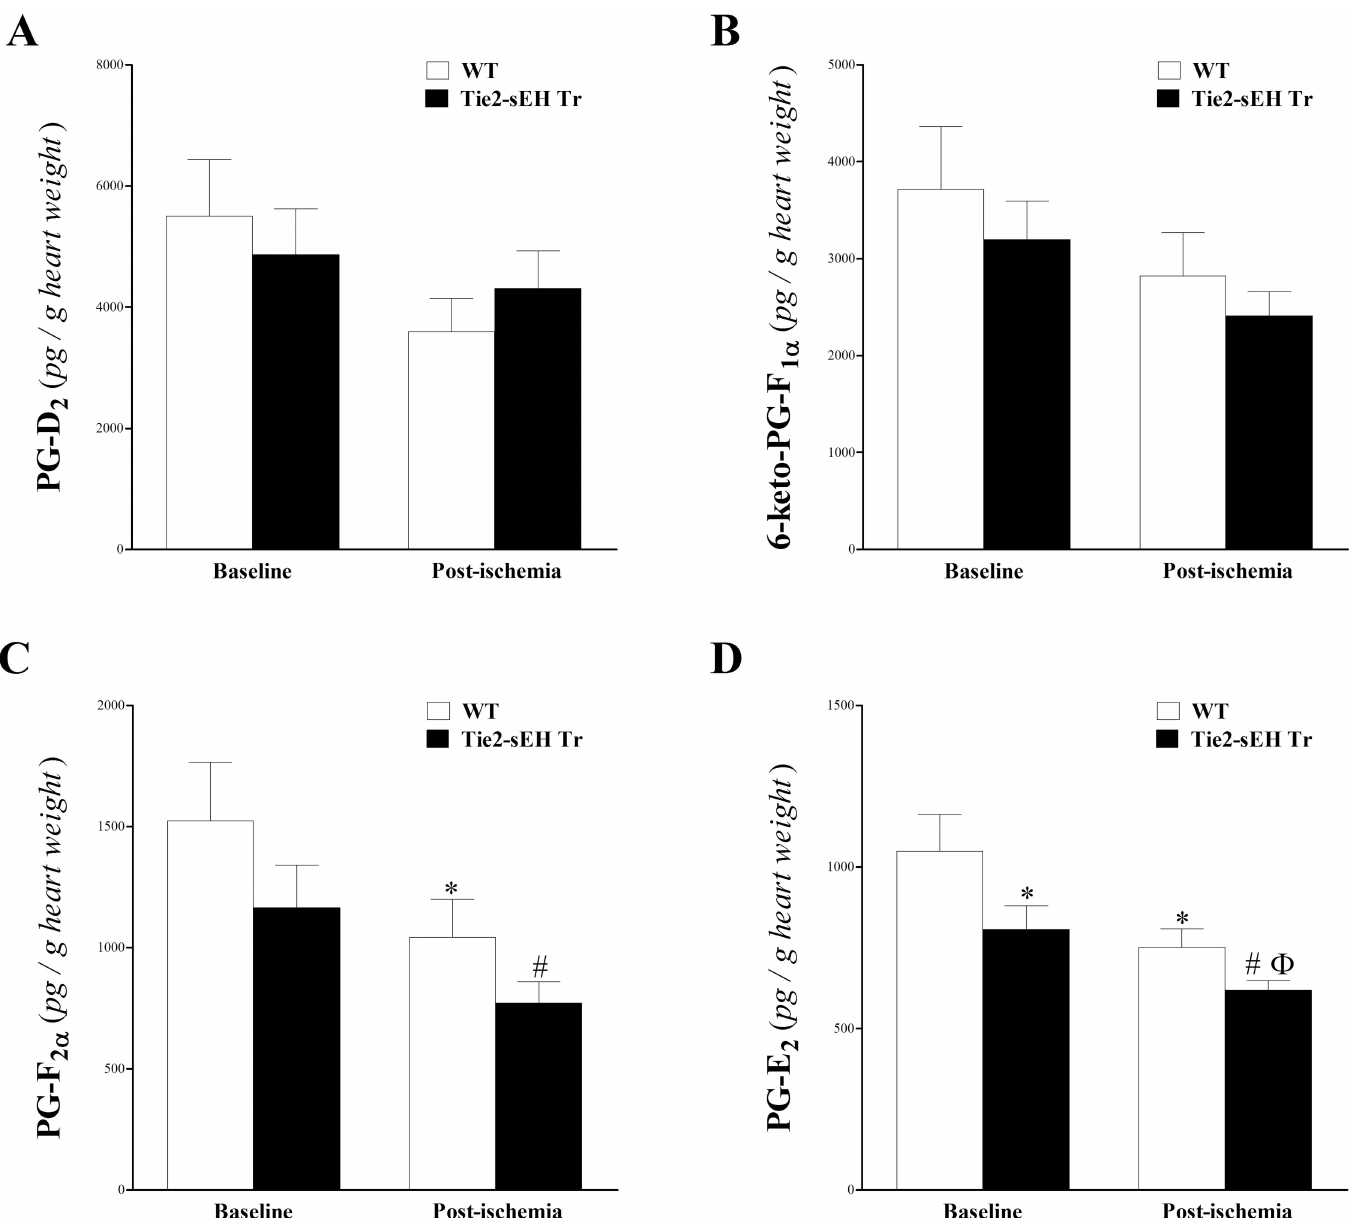
Fig 7. LC–MS/MS analysis of 6-keto-PG-F 1 α , PG-F 2 α , PG-D 2 , and PG-E 2 in WT and Tie2-sEH Tr mouse heart perfusates at baseline and post- ischemia. The levels of PG-D 2 (A) and 6-Keto-PG-F 1 α (B) were not significantly changeddue to ischemiaor between Tie2-sEH Tr and WT mice ( P > 0.05). In both Tie2-sEH Tr and WT mice, PG-F 2 α (C) was decreased post-ischemia ( P < 0.05). PG-E 2 (D) was decreased at baselineand post-ischemiain Tie2-sEH Tr comparedto WT mice ( P < 0.05), and it was also decreased in responseto ischemiain Tie2-sEH Tr mice ( P < 0.05). * P < 0.05 versus baselineWT. # P < 0.05 versus WT post-ischemia. Ф P < 0.05 versus baselineTie2-sEH Tr. n = 12 WT and 14 Tie2-sEH